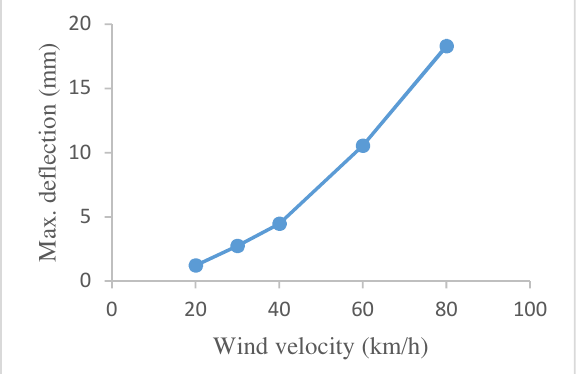
Fig. 7. Numerically evaluated static dependence of deflection ond wind load.